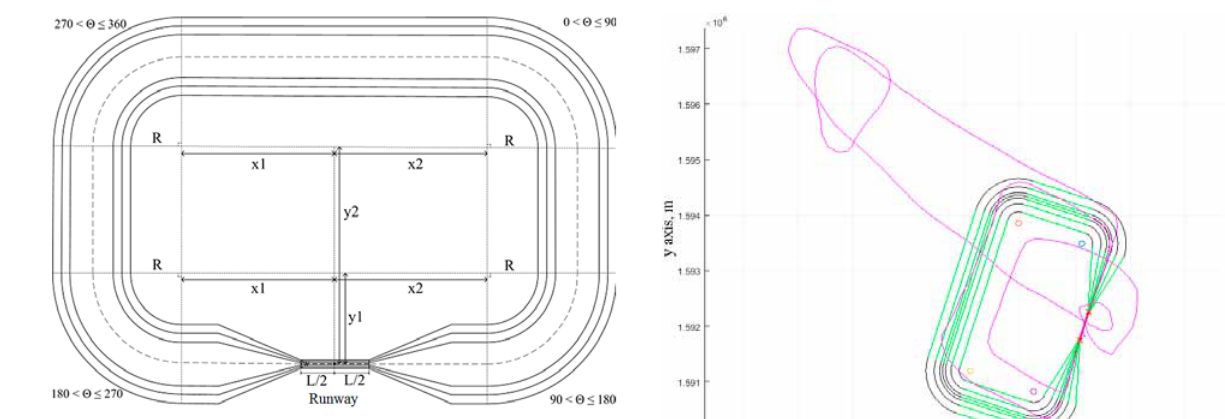
Fig. 4. Original sketch of flight assessment circuit